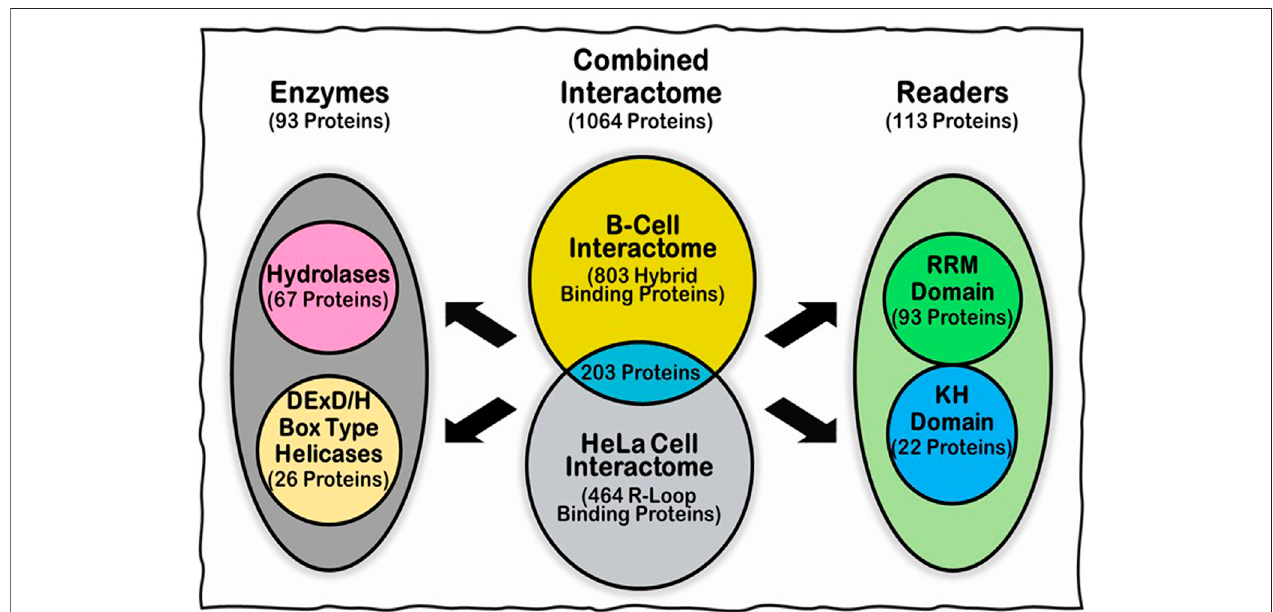
FIGURE4| SummaryoftheR-loopinteractomeand theSubgroups(Readersand Enzymes), whoseIDRswereanalyzedinthiswork.Wefocusedoninvestigating theIDRsofproteinsfromthreemajorgroups:(i)CombinedR-loopandDNA:RNAhybridInteractomesfromtheB-Cell(803proteins)andHeLaCell(464proteins)studies, respectively, not including multiple isoforms from the same protein; (ii) Readers: comprised of 22 KH domain- and 93 RRM-containing proteins from the Combined Interactomes (with two proteins containing both KH and RRM domains); and (iii) Enzymes: comprised of 26 DEAD/DEAH box type DNA:RNA helicases and the 67 P-loop triphosphate hydrolases identi fi ed in the B-Cell interactome. For more details, please see text (Wang et al.,